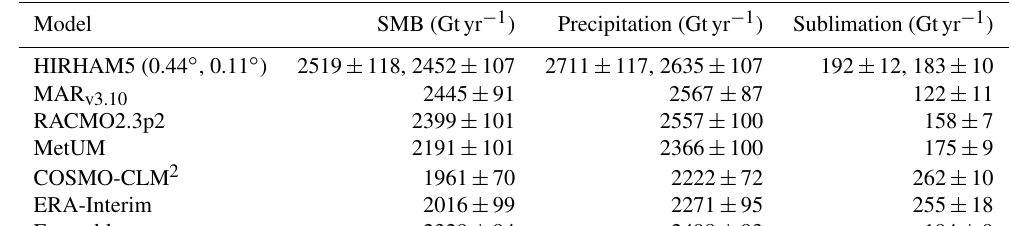
Table 4. Mean annual SMB and components on common mask for each model averaged over the 1987–2015 period, where all the models overlap. Standard deviations are also shown. SMB is calculated using the simple Eq. (1) to enable a fair comparison.